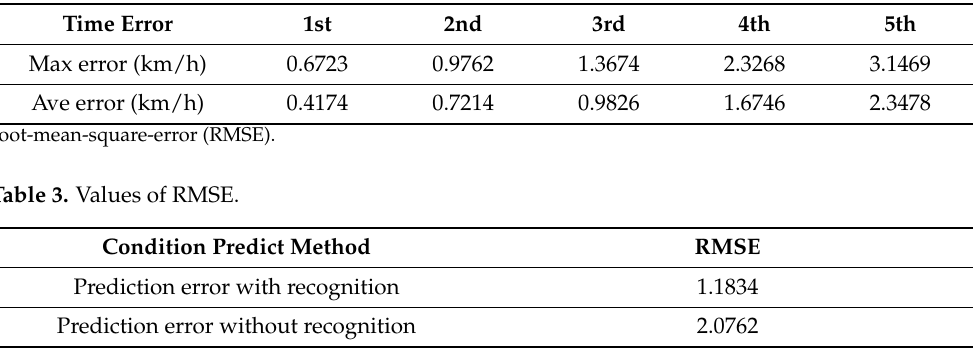
Table 2. Prediction error without pattern recognition.